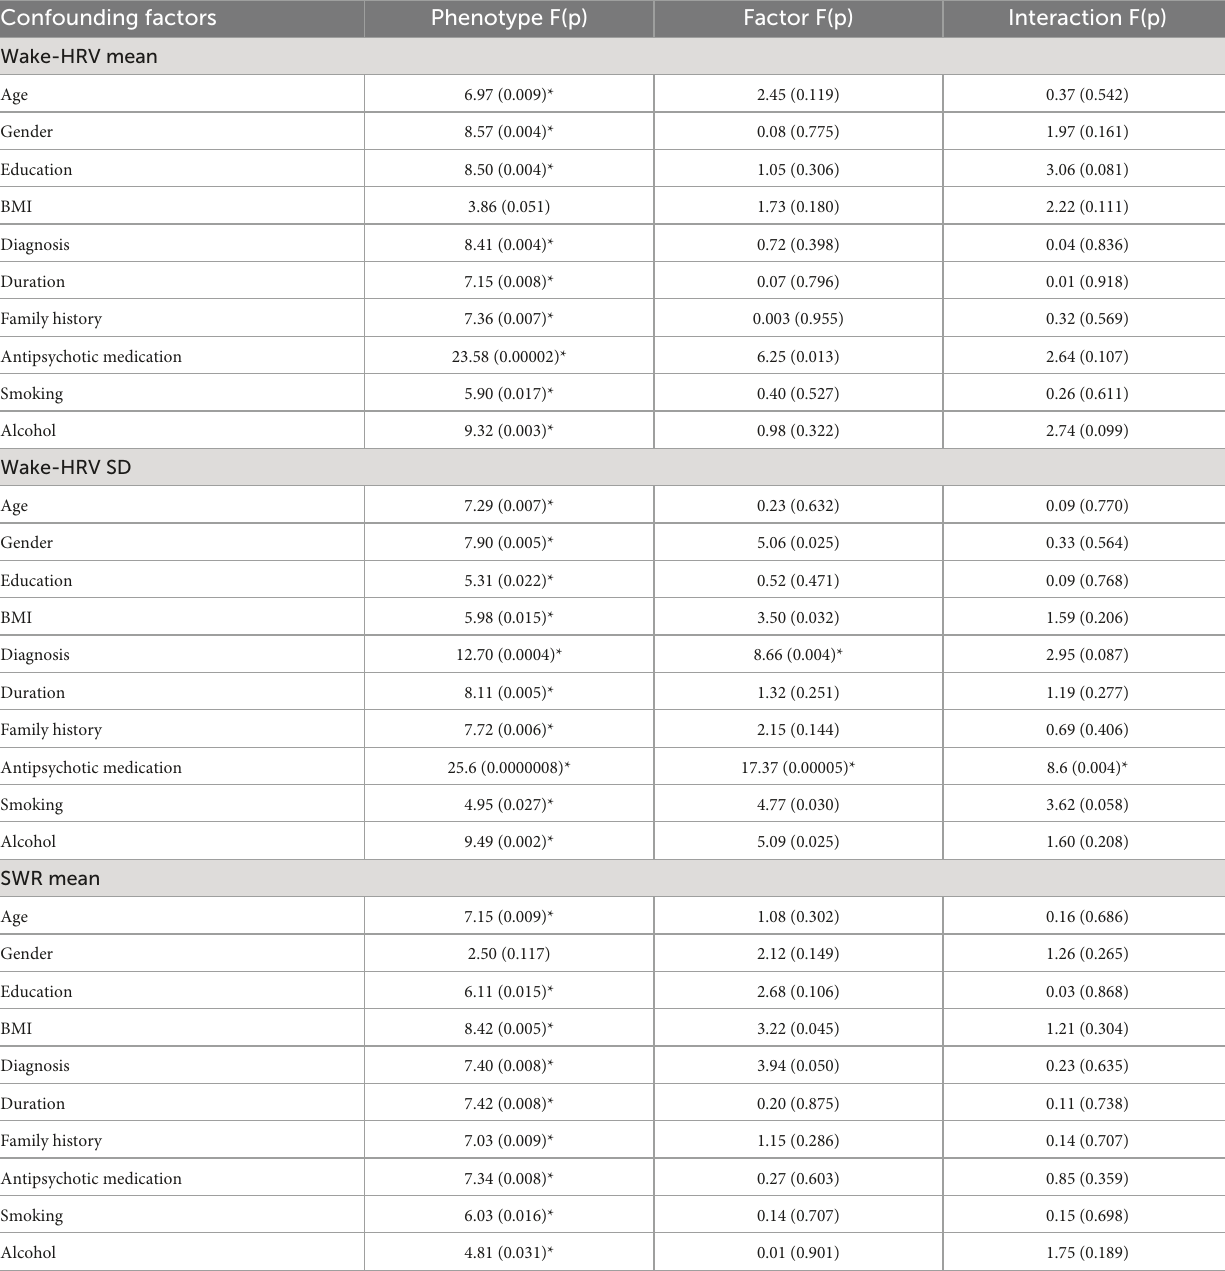
TABLE 5 Digital phenotype interactions with demographic, clinical and pharmacological factors in predicting negative